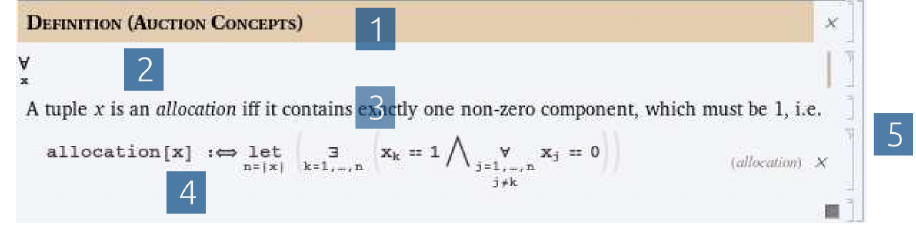
Fig. 2. Theorema environment expressing the definition of a new